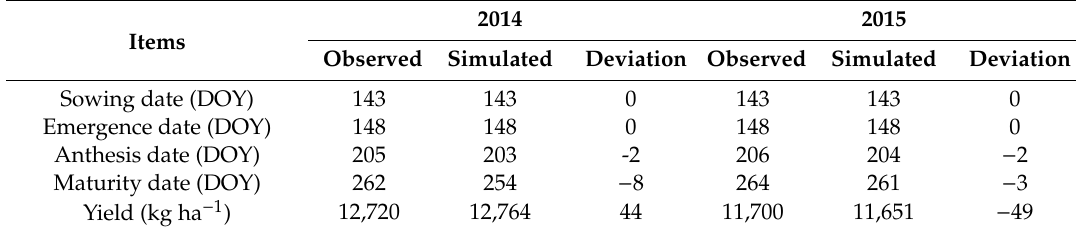
Table 4. Comparisons between observed and simulated phenology and yield for single early maize. 2014 2015 Items Observed Simulated Deviation Observed Simulated